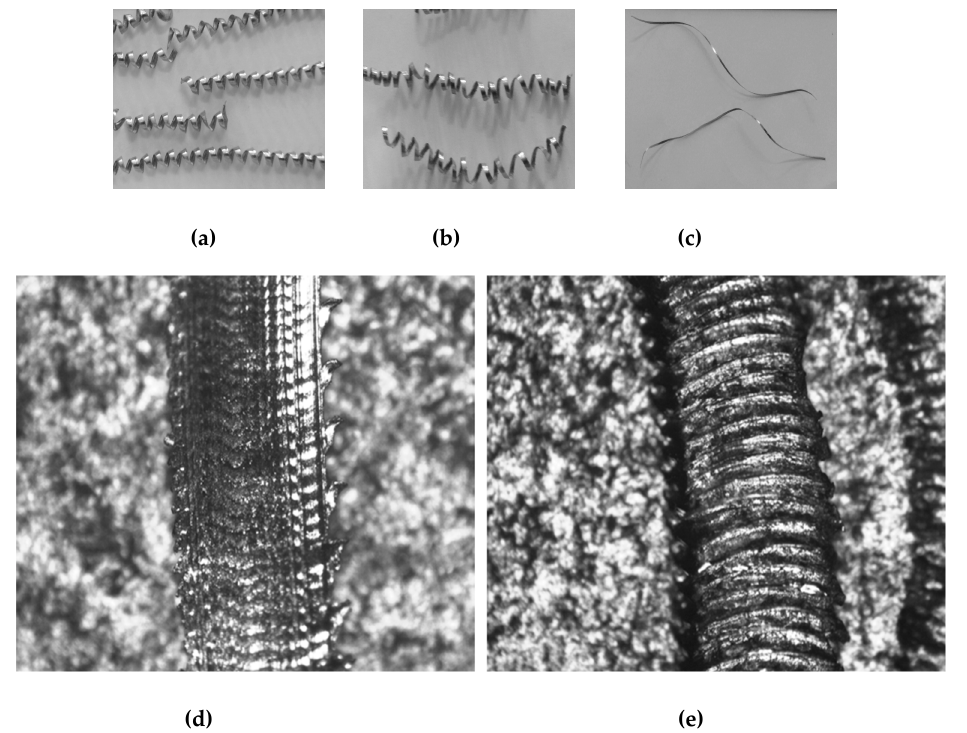
Figure 10. ( a – e ) Chips produced at various machining conditions. Figure 10. ( a )–( e ) Chips produced at various machining conditions. Figure 10. ( a )–( e ) Chips produced at various machining conditions.